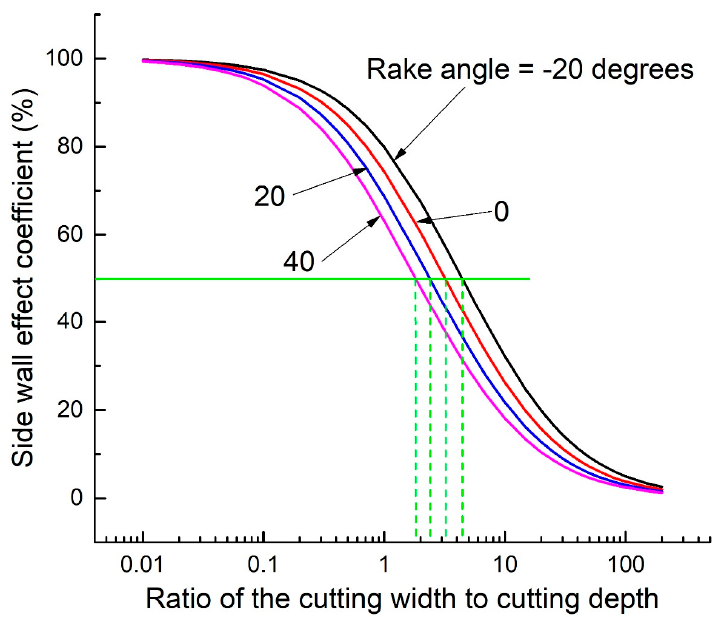
Figure 16. Relationship between sidewall effect coefficient and the ratio of cutting width to cutting depth at different rake angles.